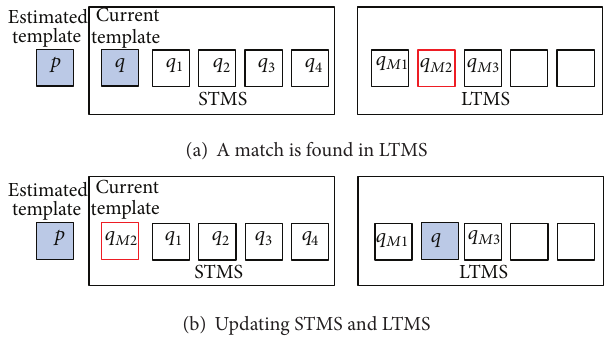
Figure 7: Illustration of recalling and